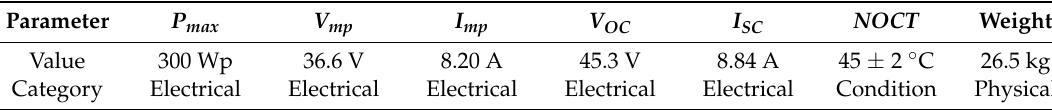
Table 2. The models and parameters of senores.